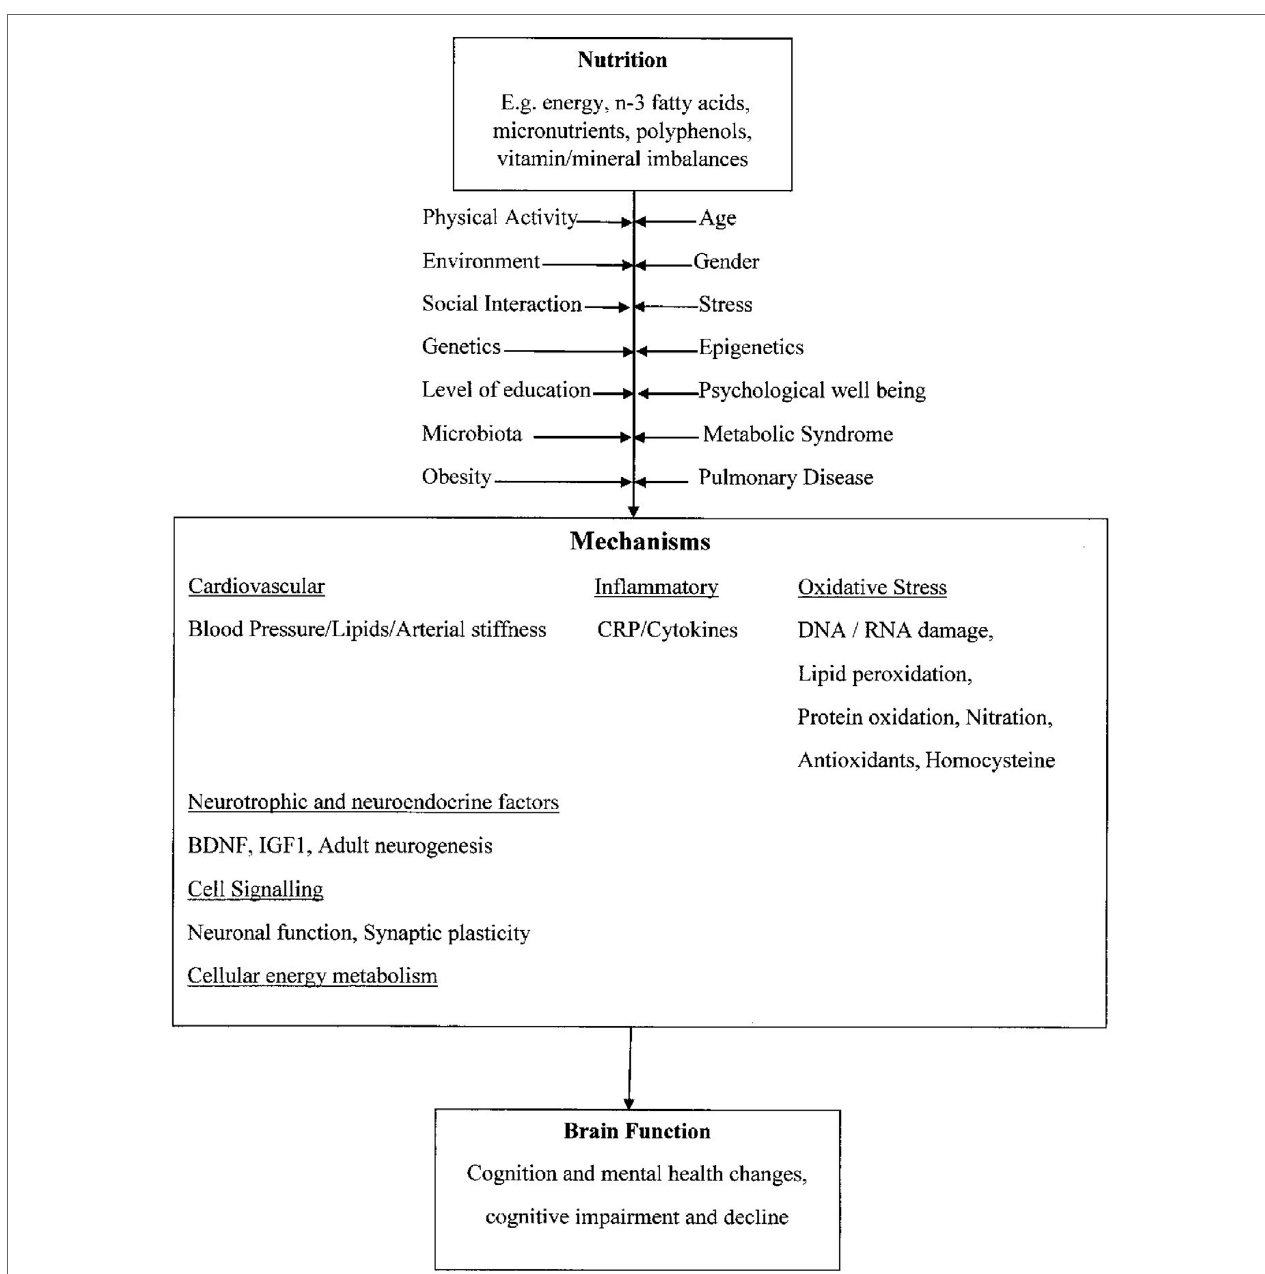
FiGURe 1 | Proposed mechanisms that link nutrition to changes in brain function . Adapted from Dauncey (23), with permission to reprint from Cambridge Press and authority to